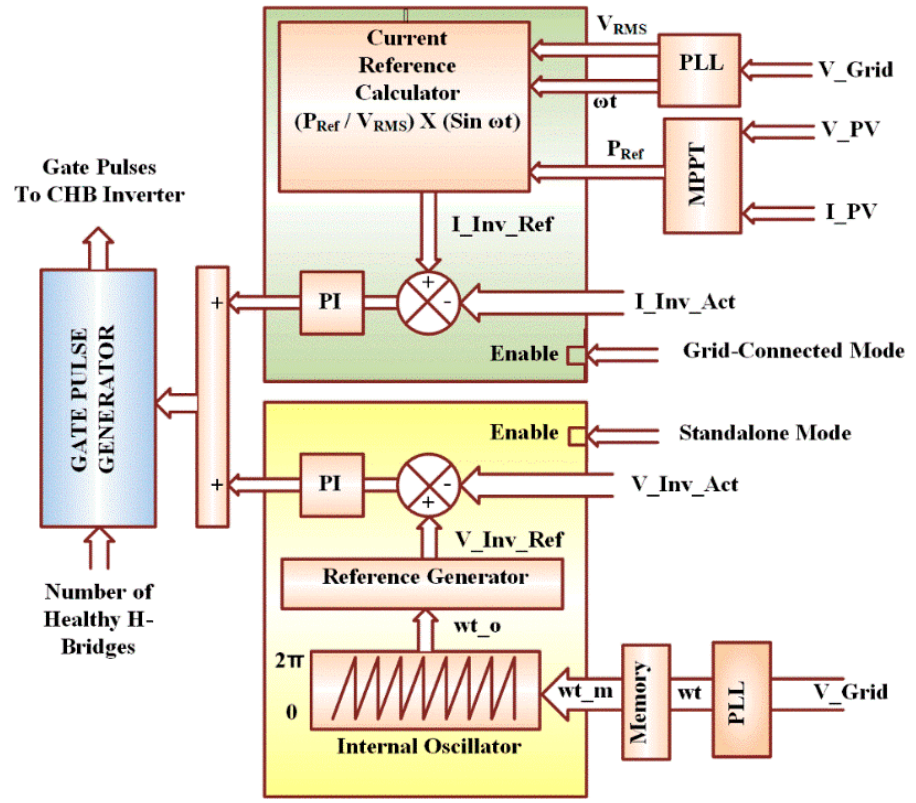
Figure 5. Control diagram for the CHB inverter in hybrid PV-ESS .